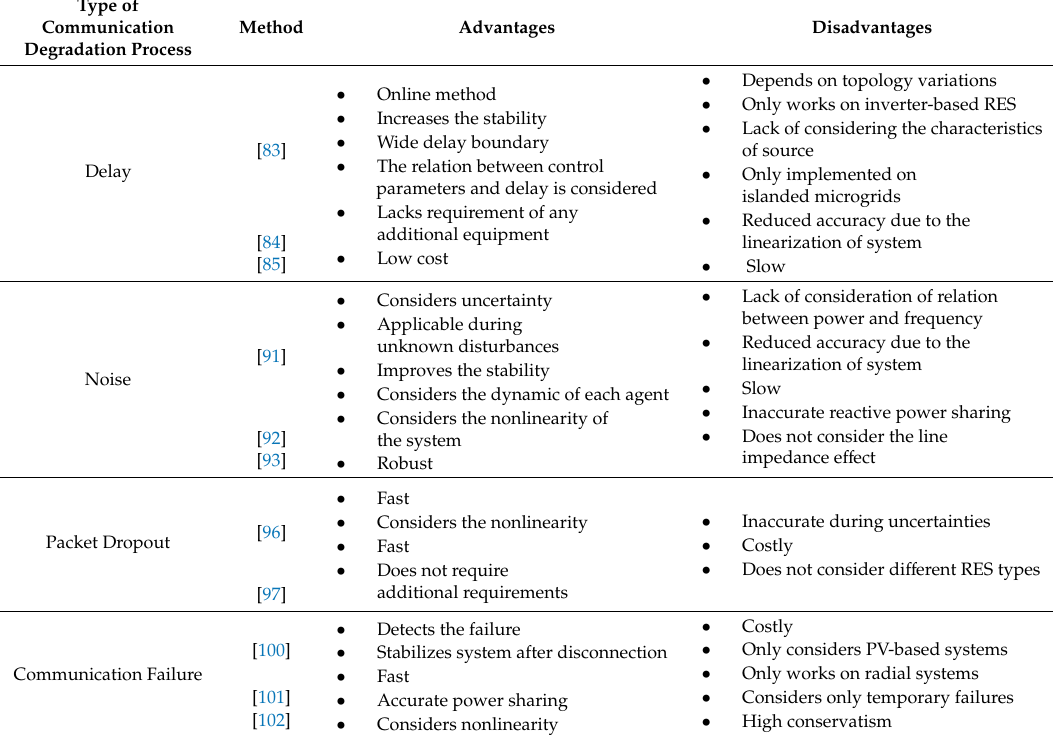
Table 2. The summary of the communication degradation processes